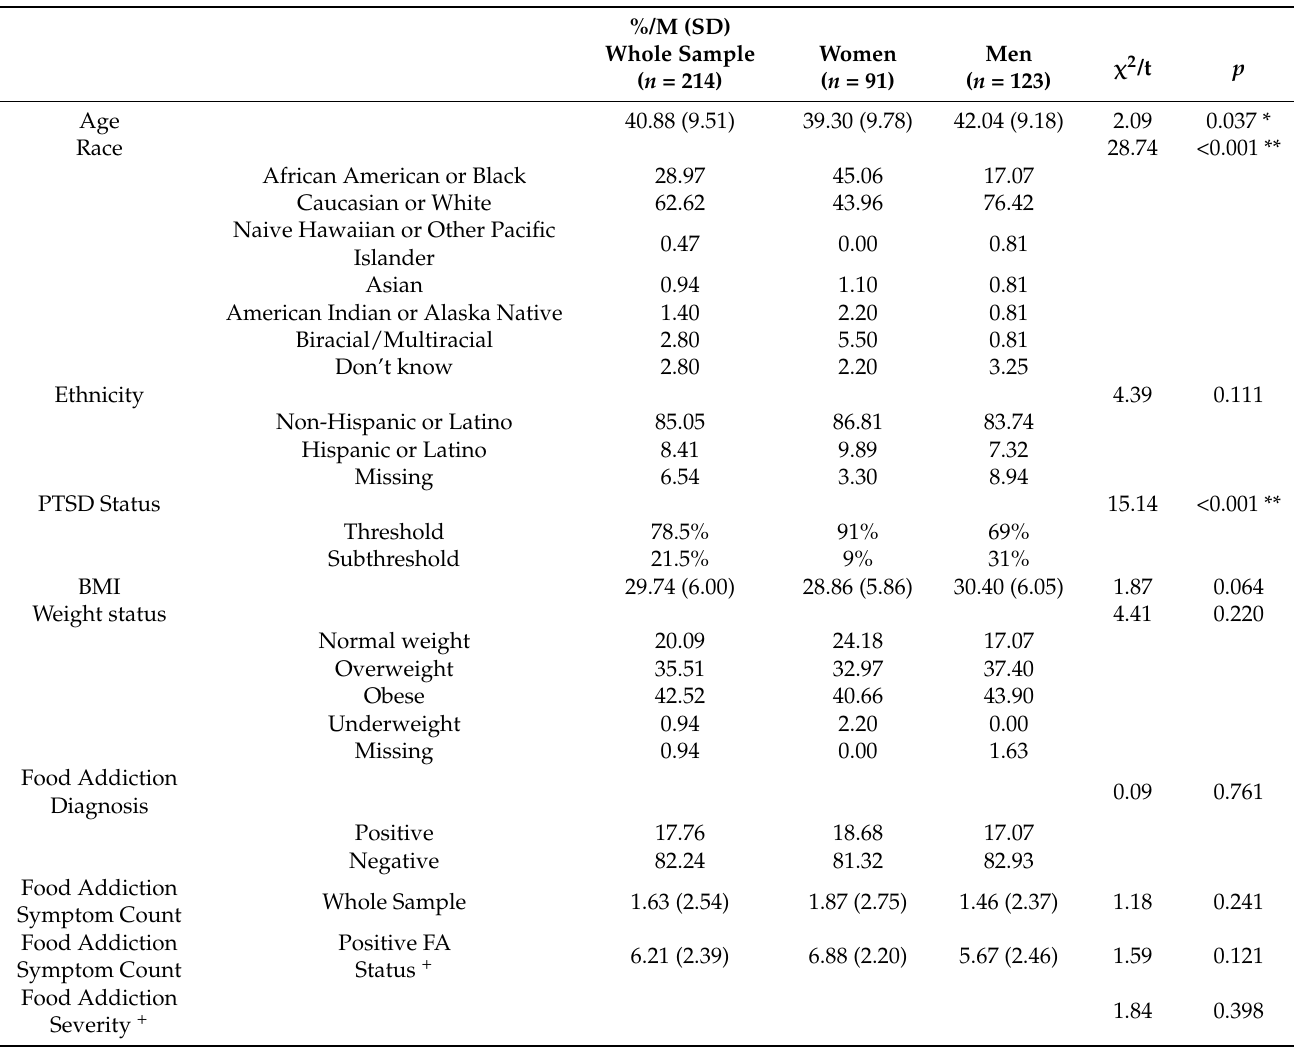
Table 1. Participant